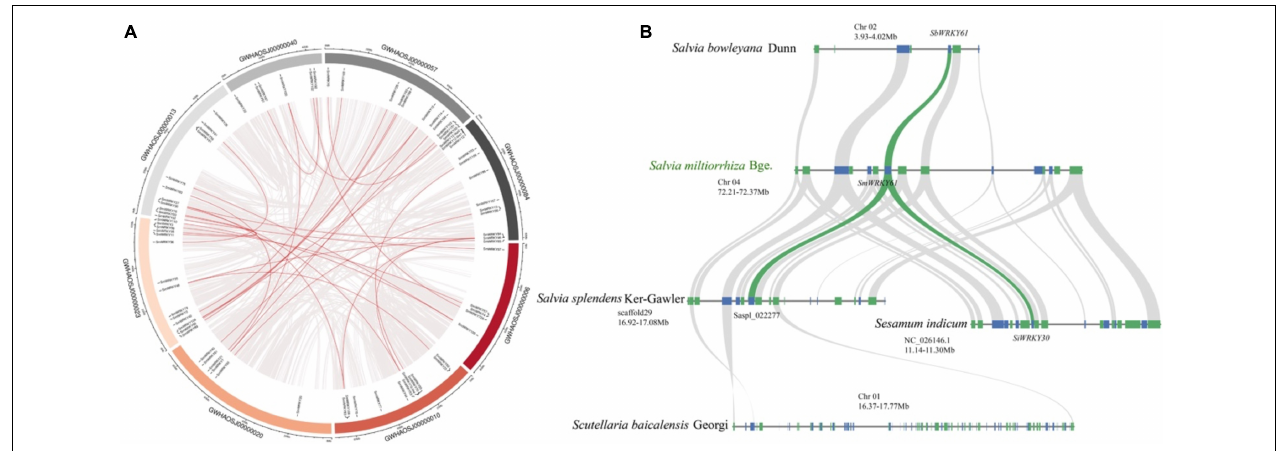
FIGURE 6 | Collinearity analysis of SmWRKYs . (A) Collinearity analysis and chromosomes distribution of SmWRKYs in the S. miltiorrhiza genome. The gray lines mean all synteny blocks in the S. miltiorrhiza genome, and the red lines mean duplicated WRKY pairs in the S. miltiorrhiza genome. (B) Syntenic analysis of the WRKY61 cluster by comparison to S. indicum, S. miltiorrhiza, S. bowlevana , S. splendens, and S. baicalensis